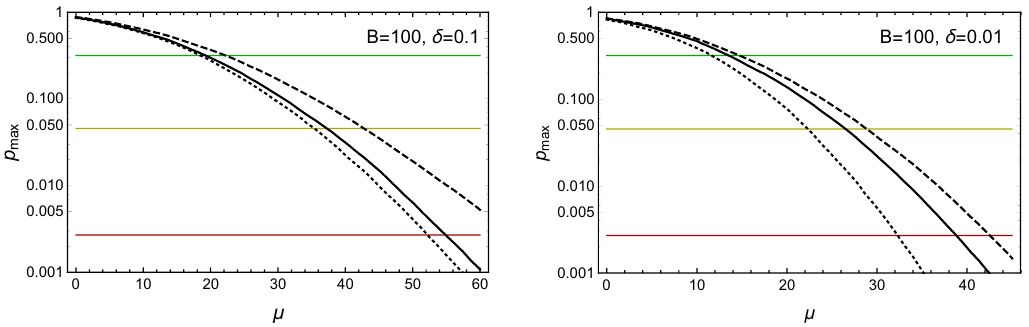
Figure 6 . The expected p -value for B = 100, (cid:14) = 0 : 1 (left) and (cid:14) = 0 : 01